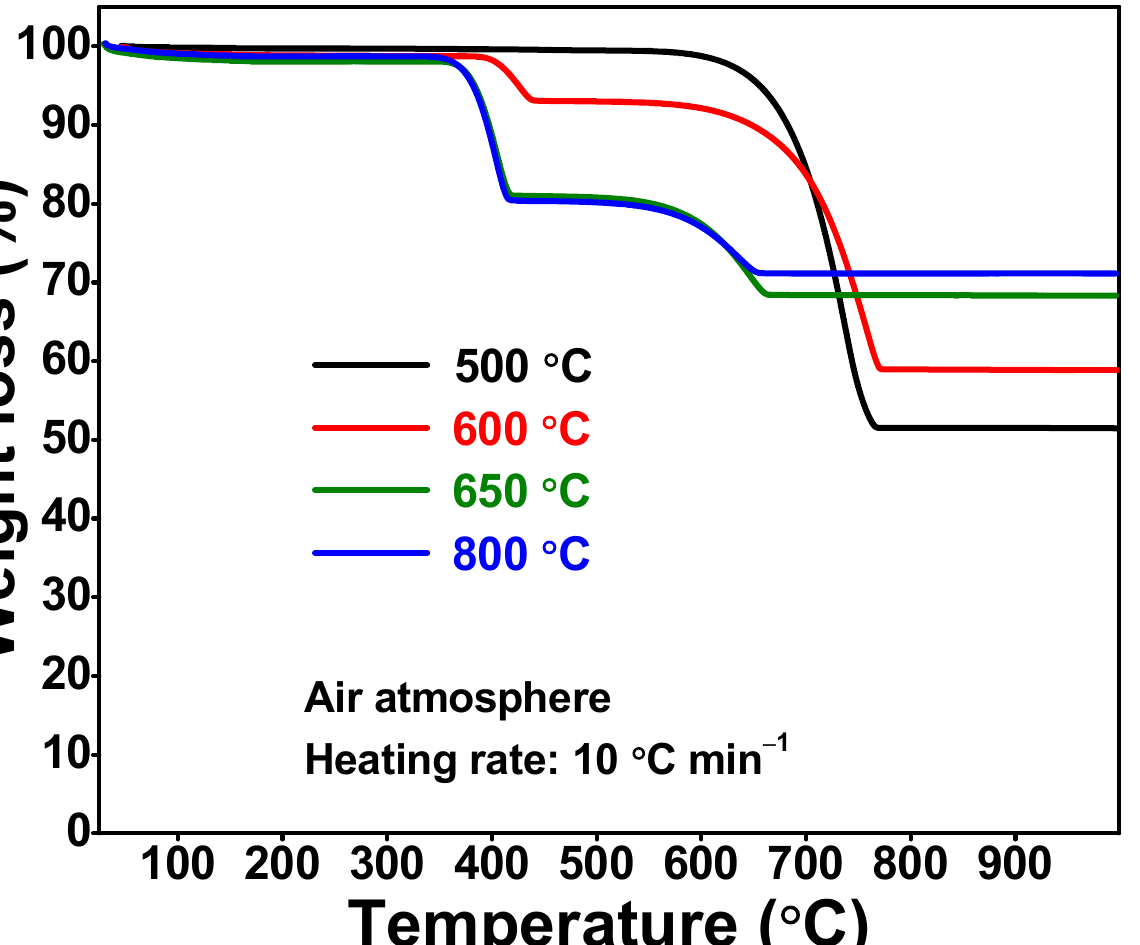
Figure 3. TGA curves of CCNPs and CONPs from calcium oleate at different carbonization/calcination temperatures.